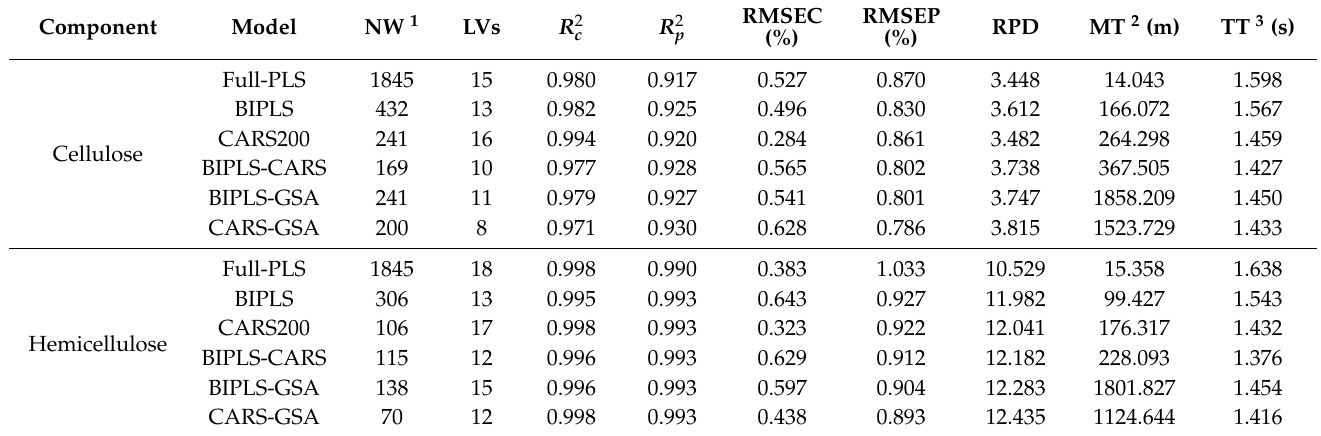
Table 3. The results for wavelength selection.